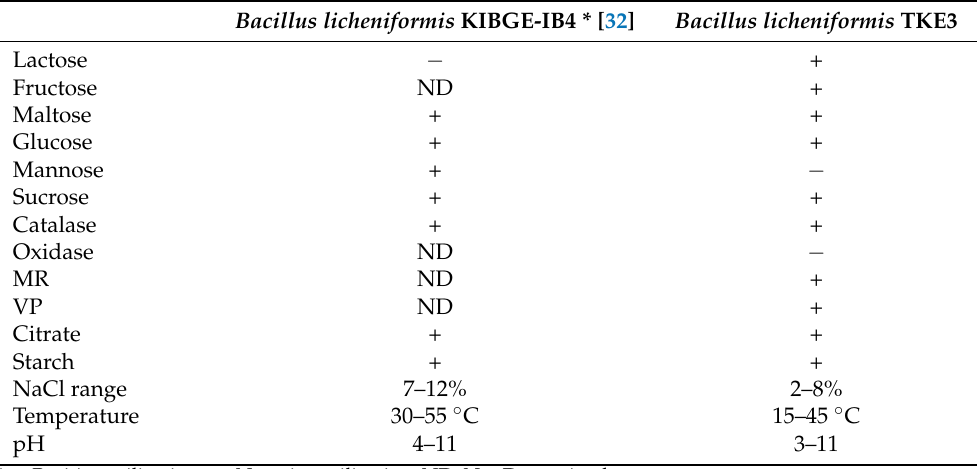
Table 2. Physiological and biochemical characteristics of B. licheniformis TKE3.